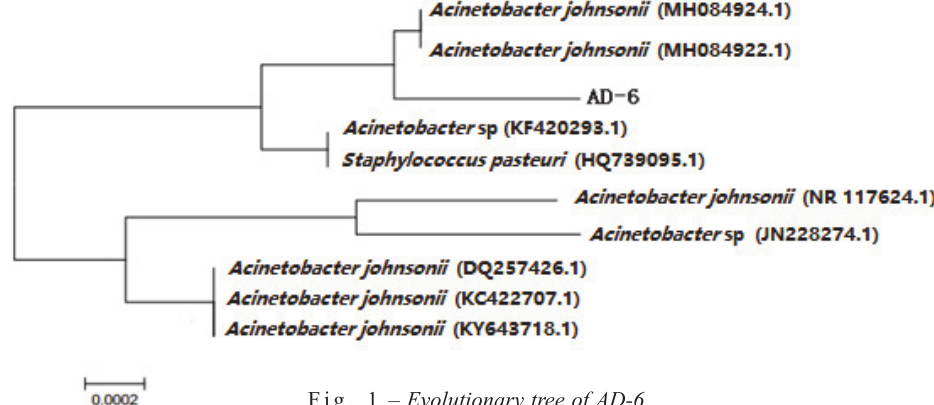
Fig. 1 – Evolutionary tree of